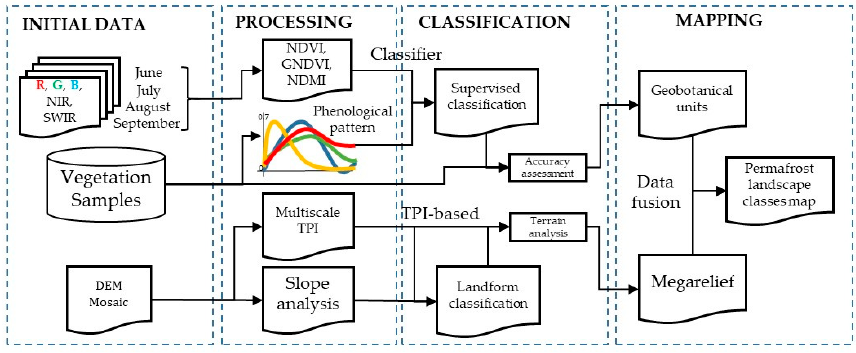
Figure 2. The general scheme of the methodological